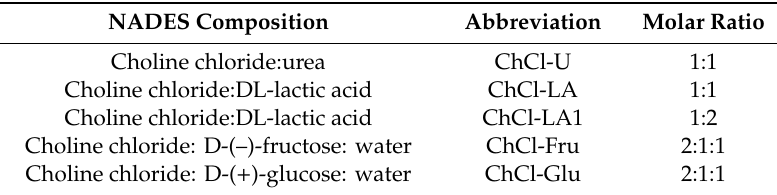
Table 1. Composition of natural deep eutectic solvents (NADESs).